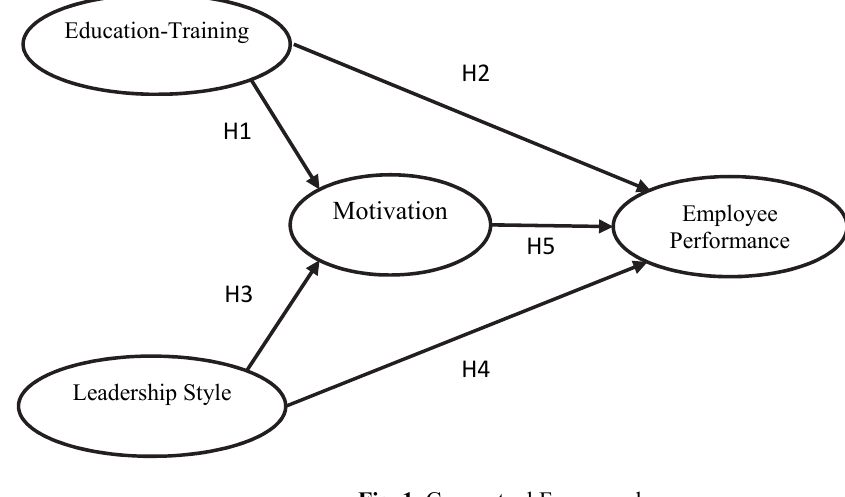
Fig. 1. Conceptual